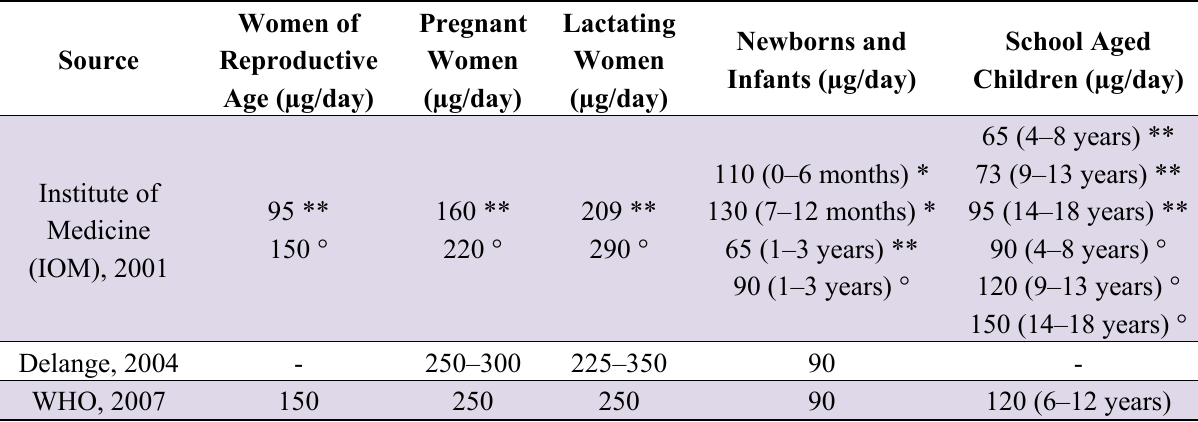
Table 2. Recommended iodine